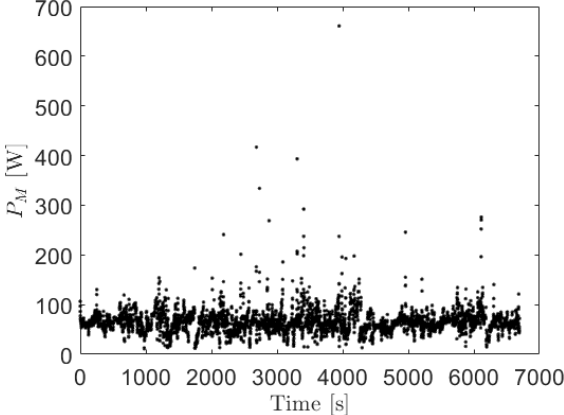
Figure 4. Time histories of the sUAV motor power.